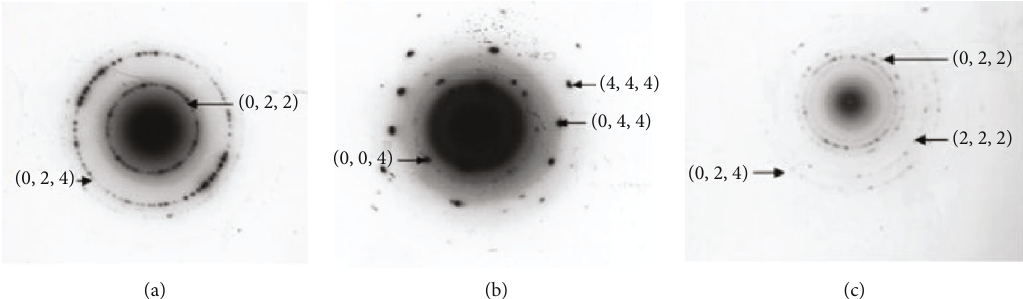
Figure 2: Di ff raction pattern of solvated metal quantum dots in 2-ethoxyethanol: (a) gold, (b) silver, and (c)